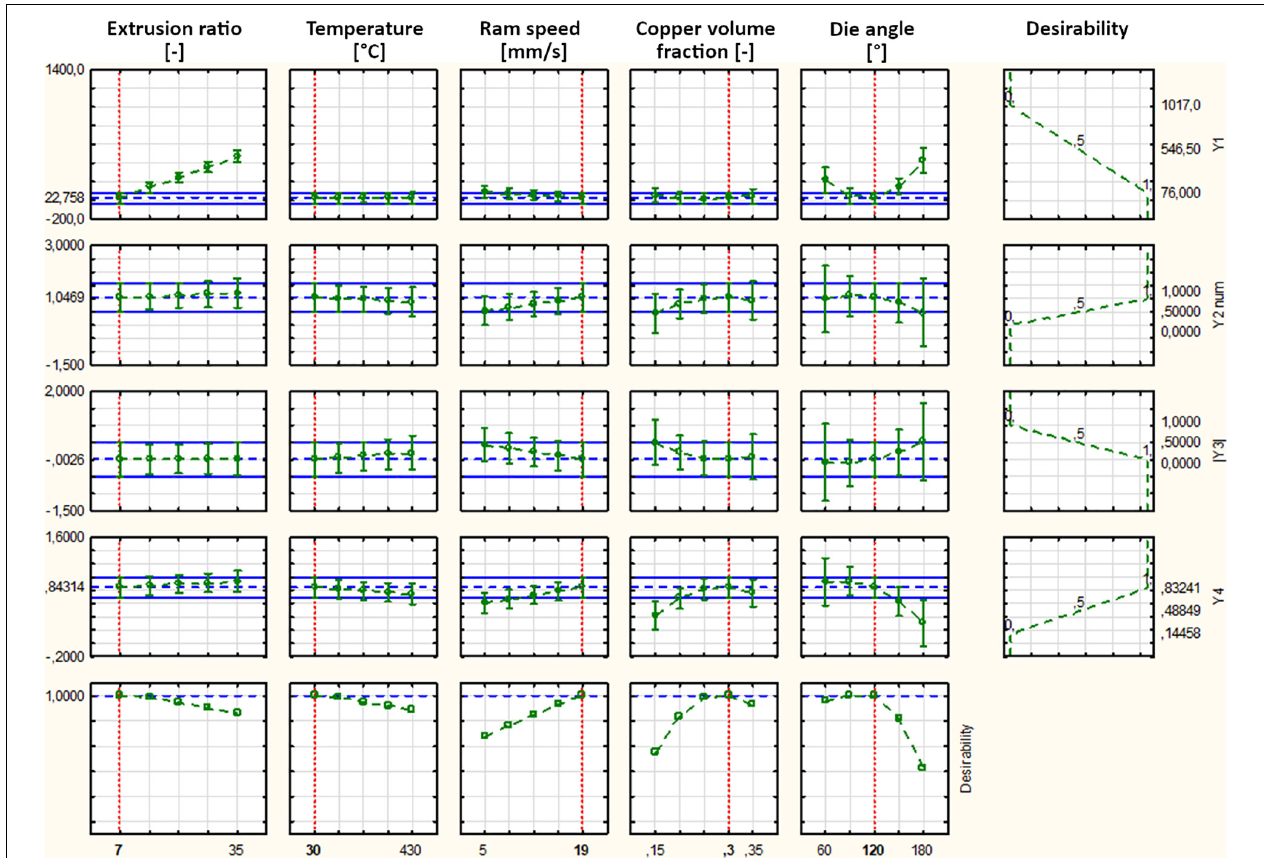
FIGURE 8 | Plot of profiles for predicted values of all response variables Y1, Y2, | Y3|, and Y4 with confidence intervals and desirability